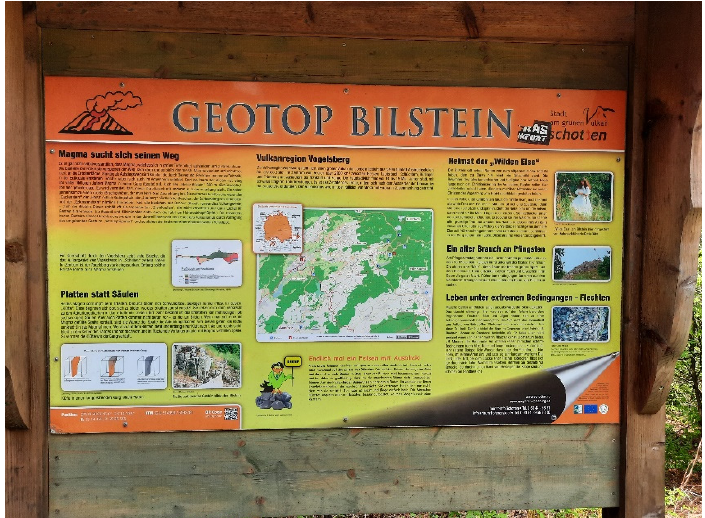
Figure 5. Panel with regionally specific references. National Vogelsberg Geopark (Germany) (Megerle 2021).